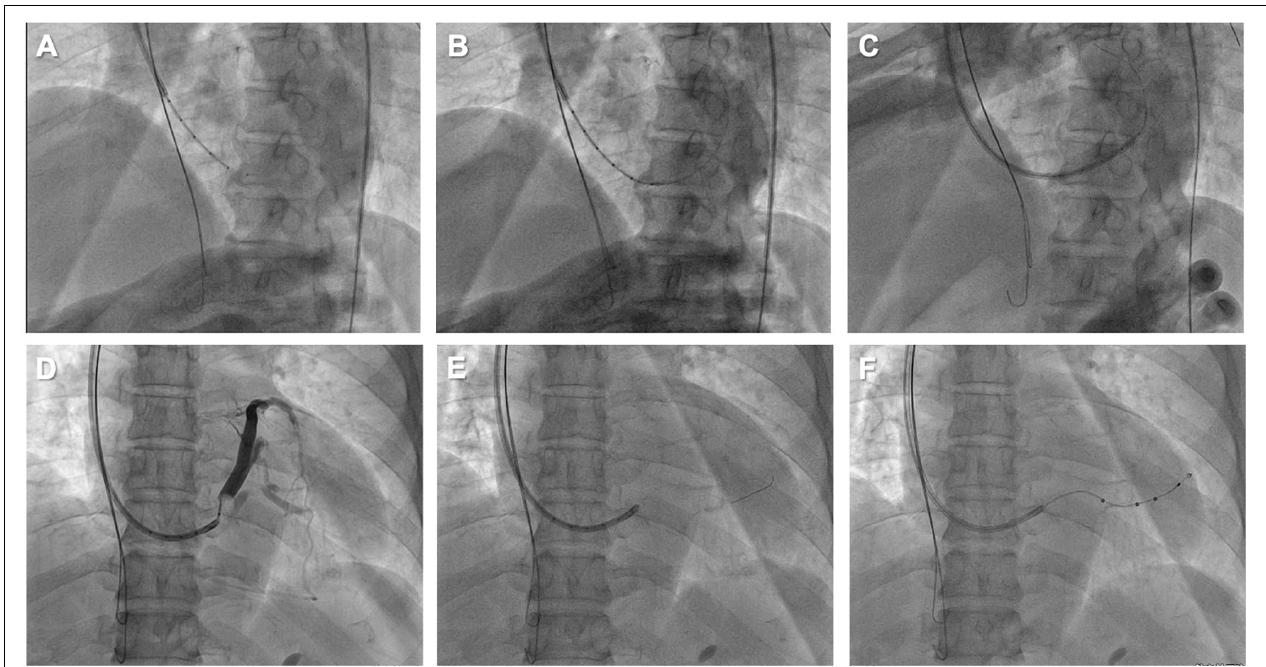
FIGURE 2 | (A) Lee’s venogram balloon catheter advanced through the 9 French CS sheath lumen to the CS ostium. (B) Radifocus guidewire was successfully cannulated into the coronary sinus through Lee’s venogram balloon central lumen. (C) The Radifocus guidewire is advanced to the distal CS and used to advance the inner guide and 9 French CS sheath into the CS. (D) Lee’s venogram balloon occlusion angiogram of the CS in anteroposterior projection. (E) The advance runthrough-NS floppy guidewire into target vein along Lee’s venogram balloon lumen. (F) Once the guidewire is into the target branch, the Lee’s venogram balloon is removed and the LV lead is advanced over the guidewire.